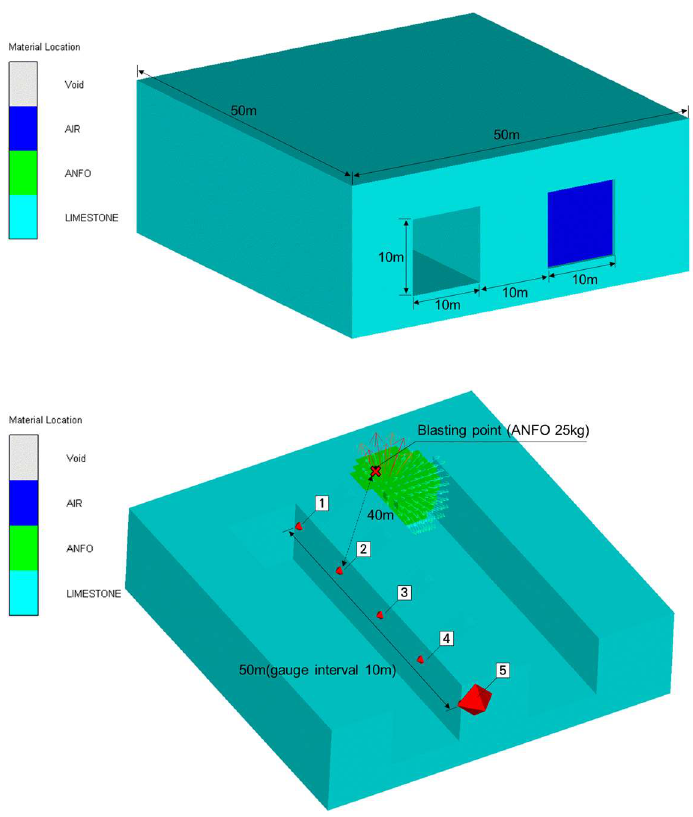
Figure 10. Layout of AUTODYN mine blasting model and vibration gauge